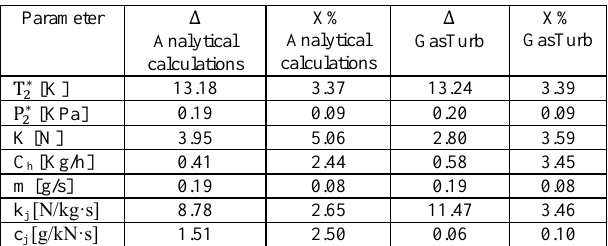
Table 1 Error values for individual parameters for selected operating point